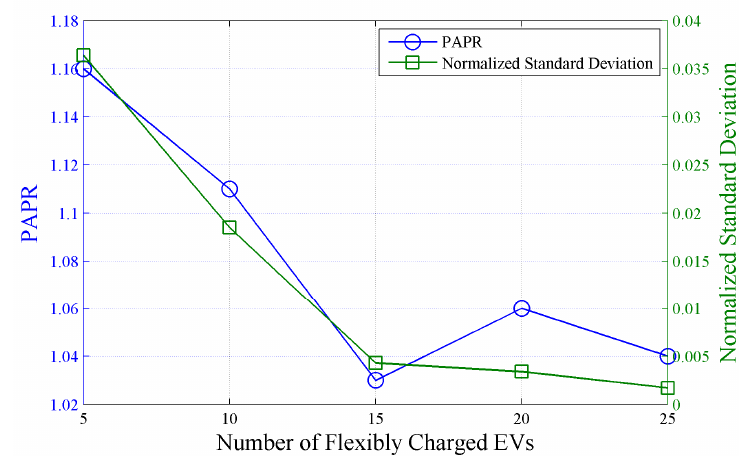
Table 3. The PAPR and the normalized standard deviation of the load profile.